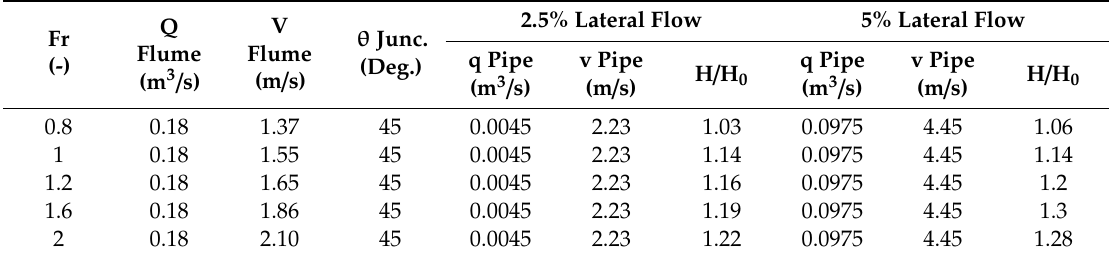
Figure 11. Maximum water height ratios in a 90 ◦ junction (narrow channel). ◦ 45 Junction Table 5. Experimental results for the 45 ◦ junction in the wide channel.